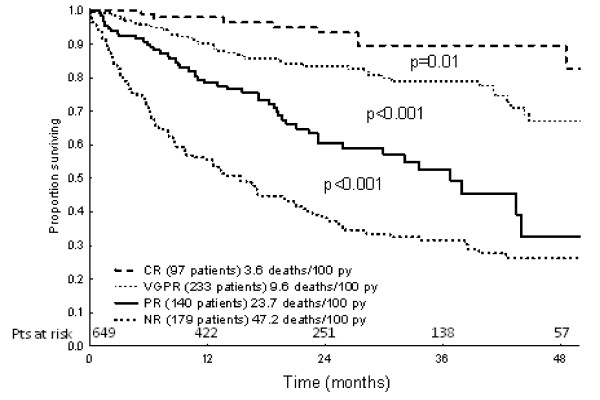
Survival in patients with AL amyloidosis by hematologic response (adapted with permission from Dr. Pallidini) [20].